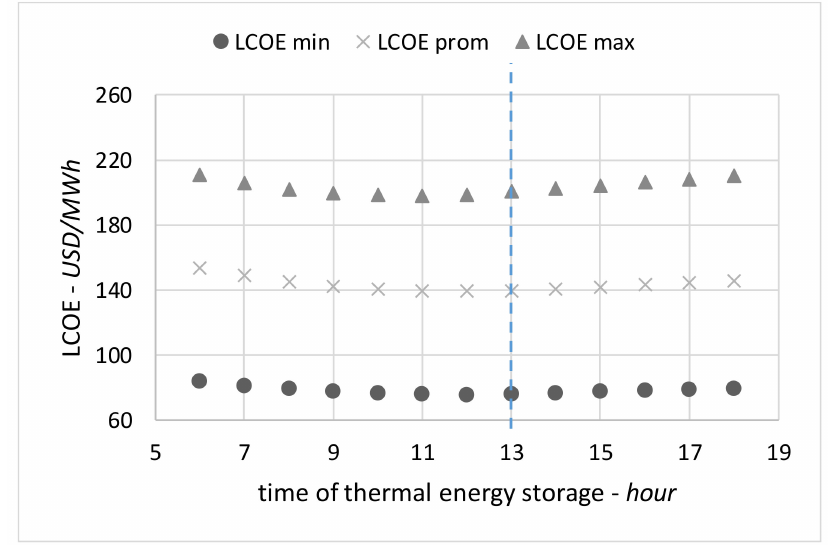
Figure 7. LCOE as a function of time of thermal energy storage.